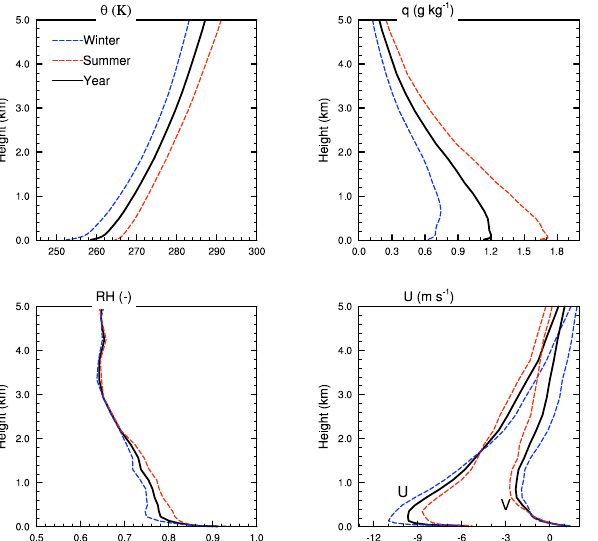
Fig. 4. Average vertical profiles in the lower atmosphere of po- tential temperature ( θ ), specific ( q ) and relative humidity (RH) and wind speed components ( U and V ) of summer (January–March and October–December), winter (April–October) and year 1997, simu- lated by RACMO2/SCM.